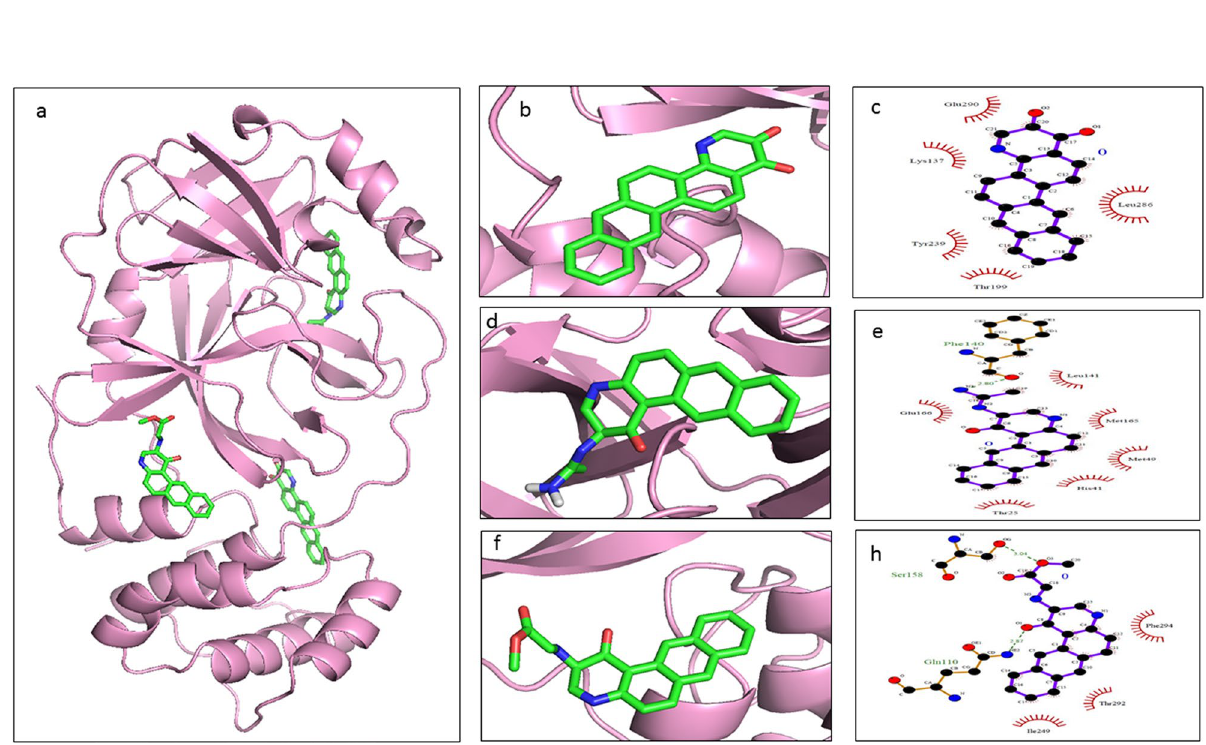
Figure 5. Docked conformations with ligand interacting plots of top 3 AQ derivatives. M pro is represented in pink ribbon format, AQ11 in yellow stick form ( b ), AQ19 in red stick form ( d ) and AQ16 in blue stick form ( f ). ( c ), ( e ) and ( h ) represent the protein–ligand interacting plots for AQ11, AQ19 and AQ16 respectively (Here the green sticks denote Carbon, blue denote Nitrogen and red denote Oxygen atoms of the